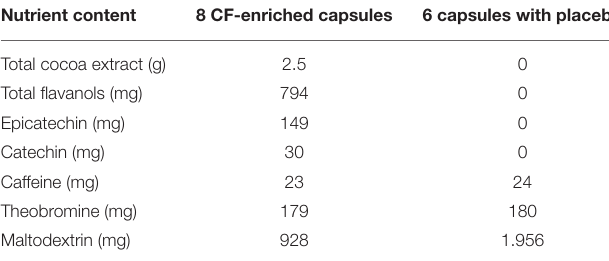
FIGURE 1 | Flowchart. FMD, flow-mediated dilation test; capillary blood, finger prick to measure capillary glycaemia (only patients with T2DM).